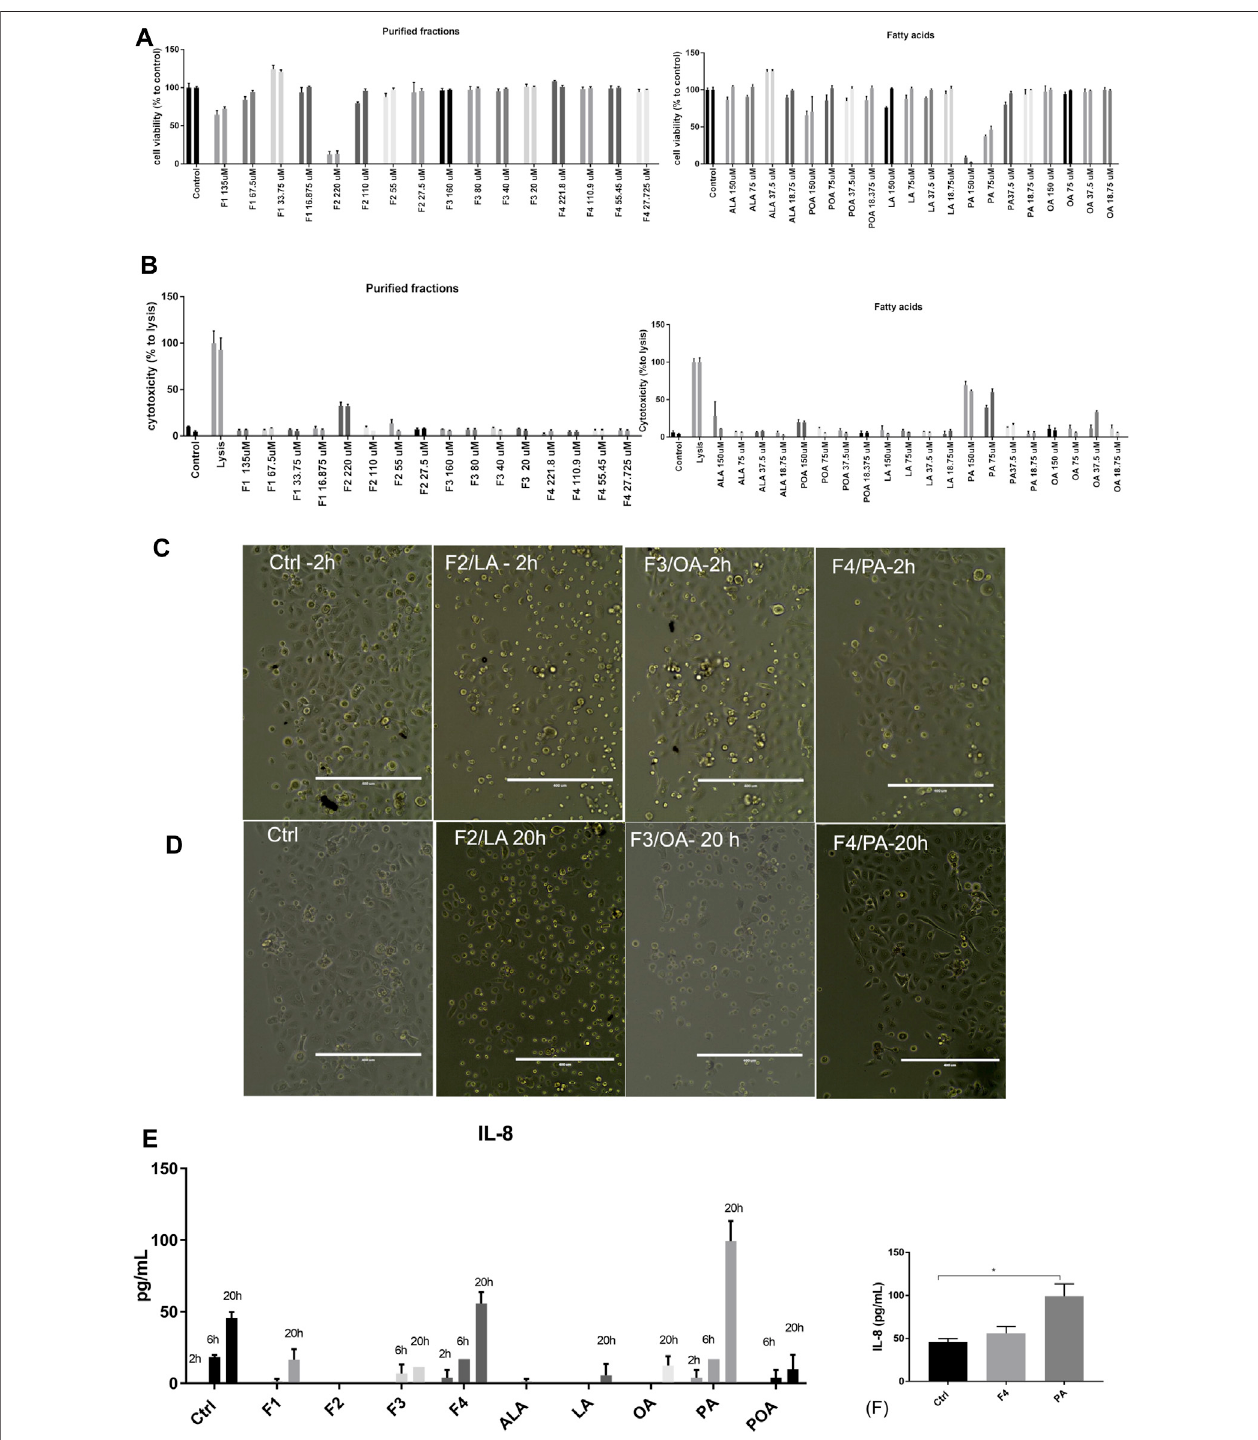
FIGURE2| Viabilityandcytotoxicityofpuri fi edfractionsonnormalhumankeratinocytes.Viabilityofcellstreatedwithpuri fi edfractionsandanalyticalstandardswas assessed by MTS (A) and LDH release (B) . Cells were incubated for 24 h ( fi rst bar of the sample) and 48 h (second bar of the respective sample) with the indicated concentrations. Bars represent the average of triplicates ± S.D. Cell morphology of cells treated with 25 µM puri fi ed fractions (F1 – F4) was assessed by phase-contrast microscopyat2 h (C) and 20 h (D) .Thenameofthefraction inthis fi gurealsoindicatestheFAenrichedintherespectivefraction(e.g.,F4/PA (cid:2) fraction4,enriched in PA). Supernatant of cells treated with 25 µM puri fi ed fractions and corresponding FA analytical standards were tested for cytokine release by multiplexing (E) and con fi rmed by ELISA (F) .